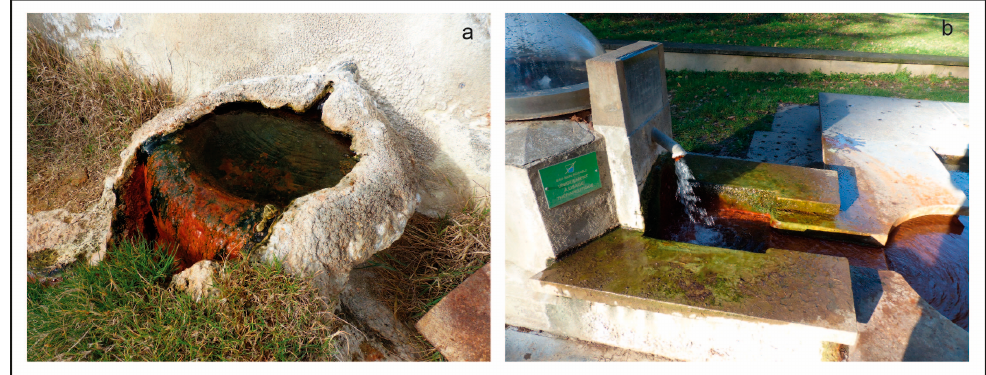
Figure 2. Photography of some studied springs: Tennis ( a ) and Lefort ( b ).